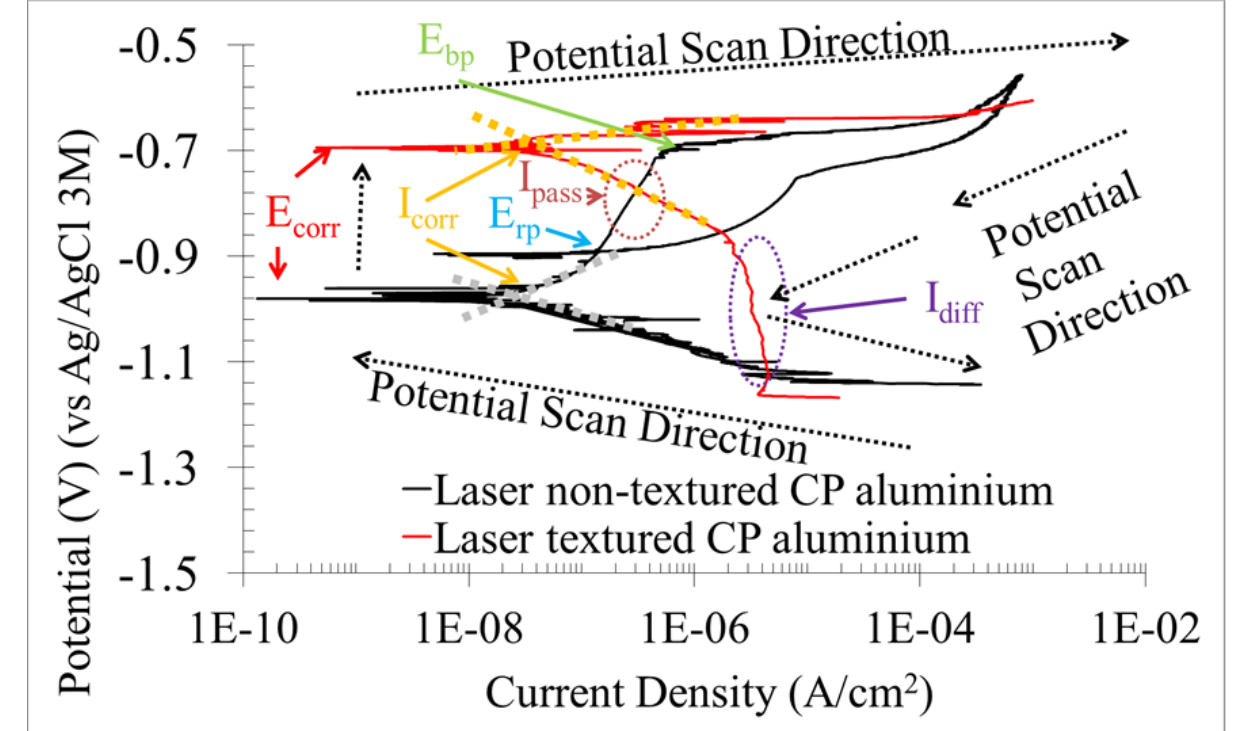
Figure 3. Sample PPC at 2 h immersion in 0.6 M NaCl.